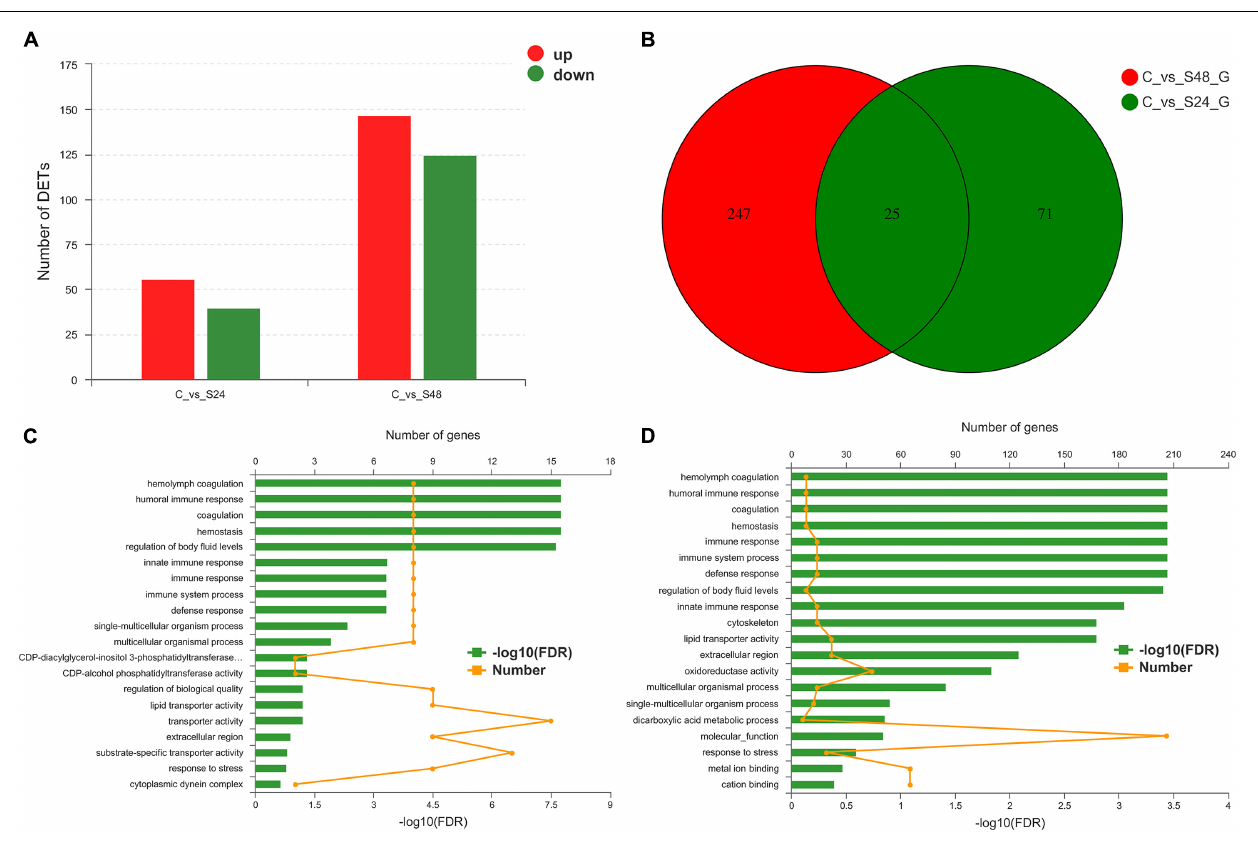
FIGURE 4 | Statistical analysis of differentially expressed genes. (A) Differentially expressed genes statistics in group C vs. S24 and C vs. S48 (C, control group; S24, acute saline-alkali stress for 24 h; S48 acute saline-alkali stress for 48 h). (B) DEGs number and Venn diagram of overlap of the different group. (C,D) The most enriched Gene Ontology (GO) term analysis and function classifications of differentially expressed genes after 24 h (C) and 48 h (D) acute heat stress.